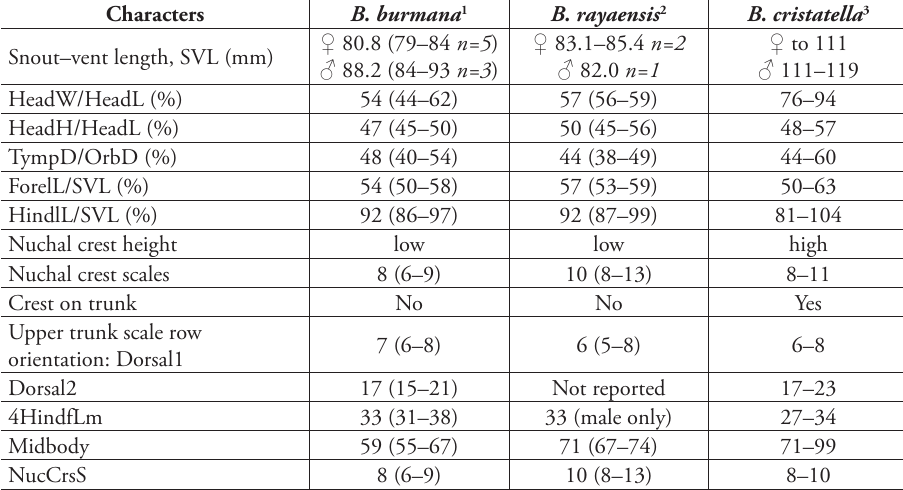
Table 2. Comparison of character metric of the three potentially allopatric species of Bronchocela in My- anmar, Thailand, and northern Peninsular Malaysia. Character abbreviations are defined in the Material and Methods section of the text. Numerical values are mean and range within